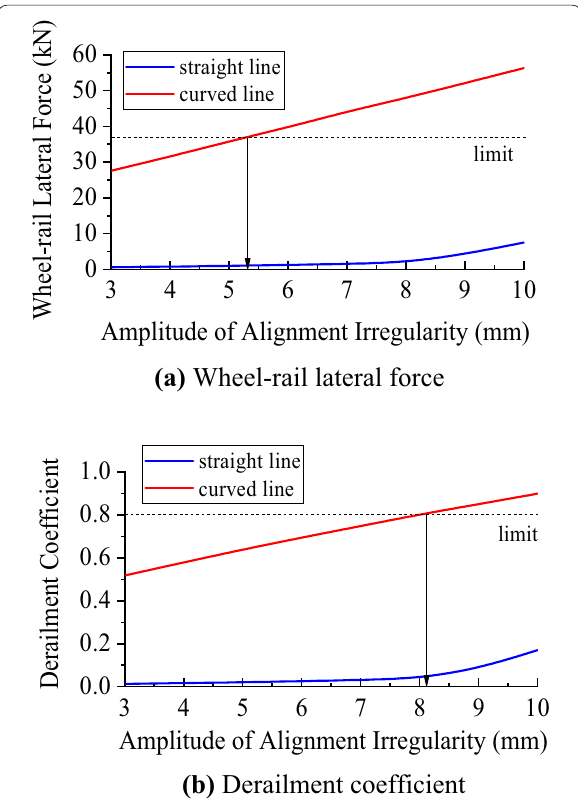
Figure 9 Influence of variation in alignment irregularity amplitude on wheel-rail lateral force and derailment coefficient under straight and curved operational line conditions